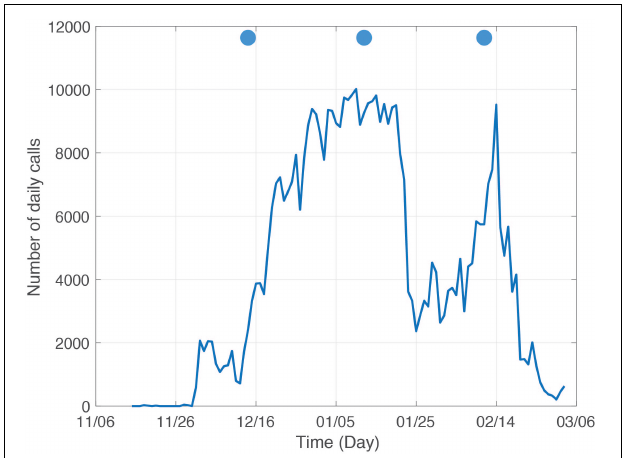
FIGURE 7 | Daily calls at Red Hind Bank fish spawning aggregation from November 2016 to March 2017. The blue disks indicate the day of full